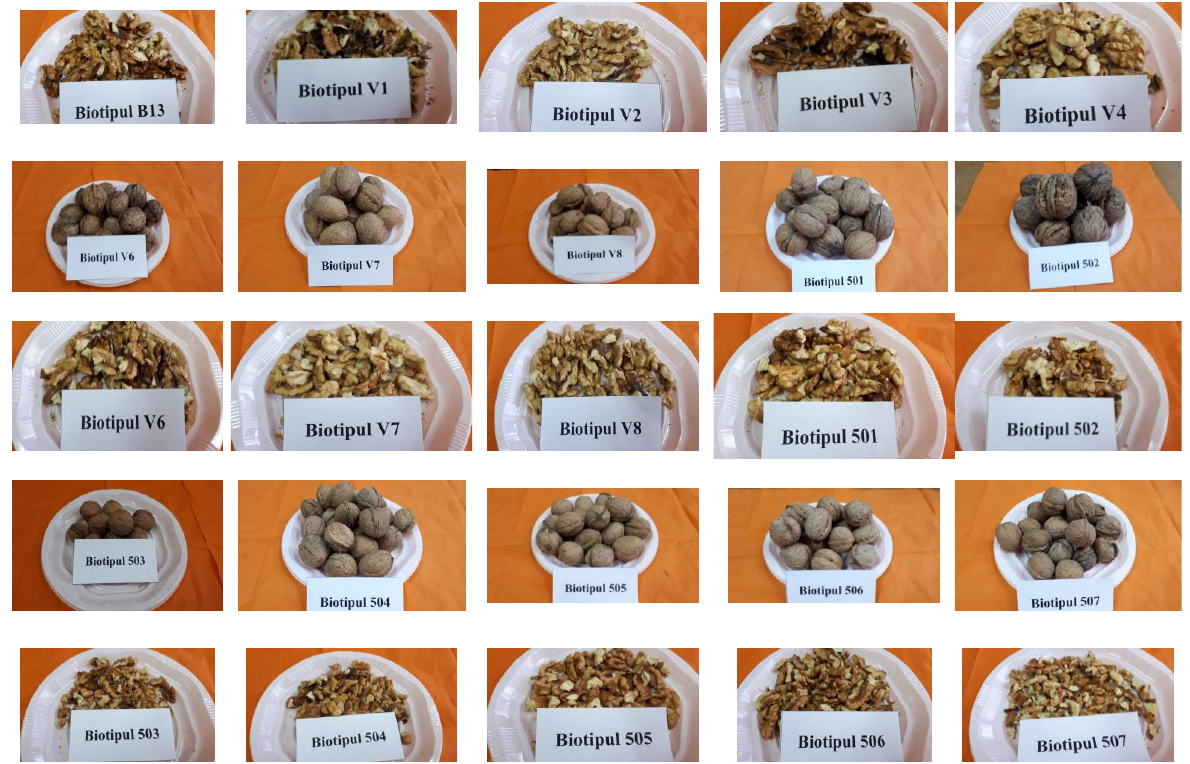
Figure 1. The walnut genotypes from west and north-west of